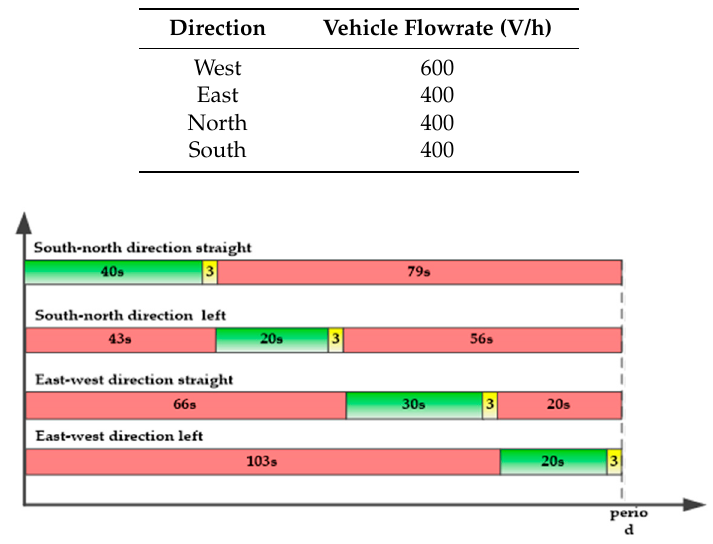
Figure 6. Intersection phase. Table 3. Simulation Setting Table.